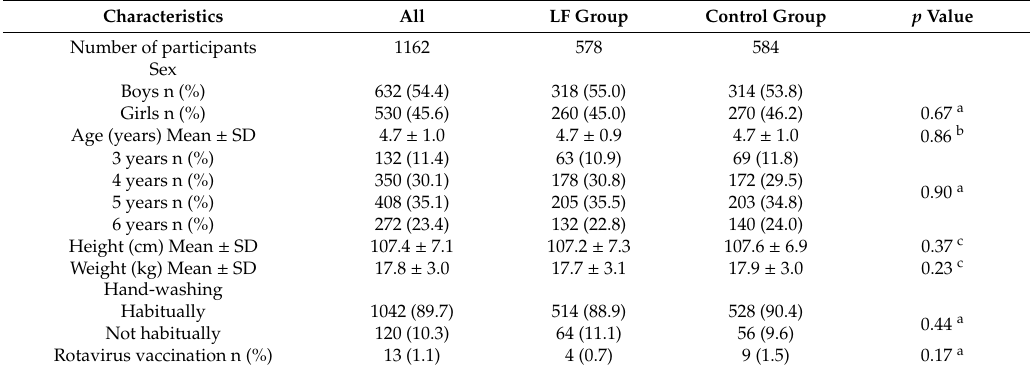
Table 1. Characteristics of 1162 participants consisting of 578 LF group and 584 Control group.